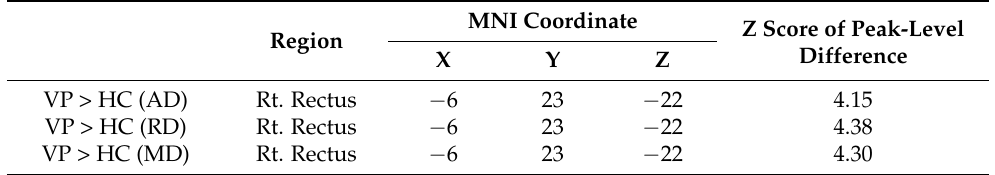
Table 3. The Montreal Neurological Institute (MNI) coordinates of regions with significantly different AD, RD, and MD values in WM tissues between VP and HC